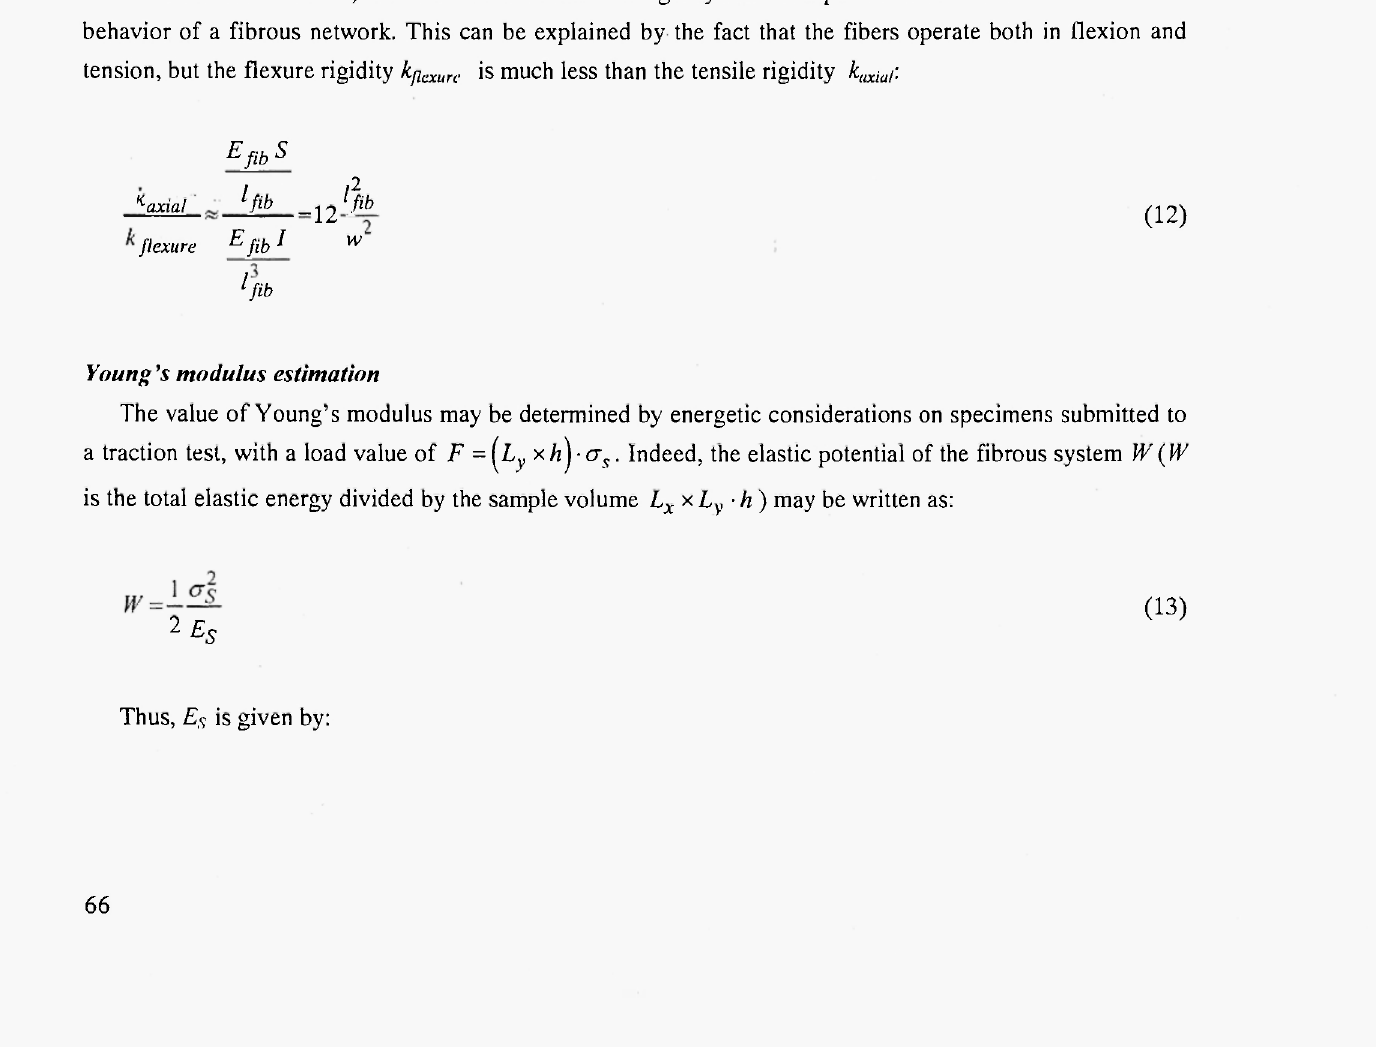
Fig. 5: The stress extrema for all